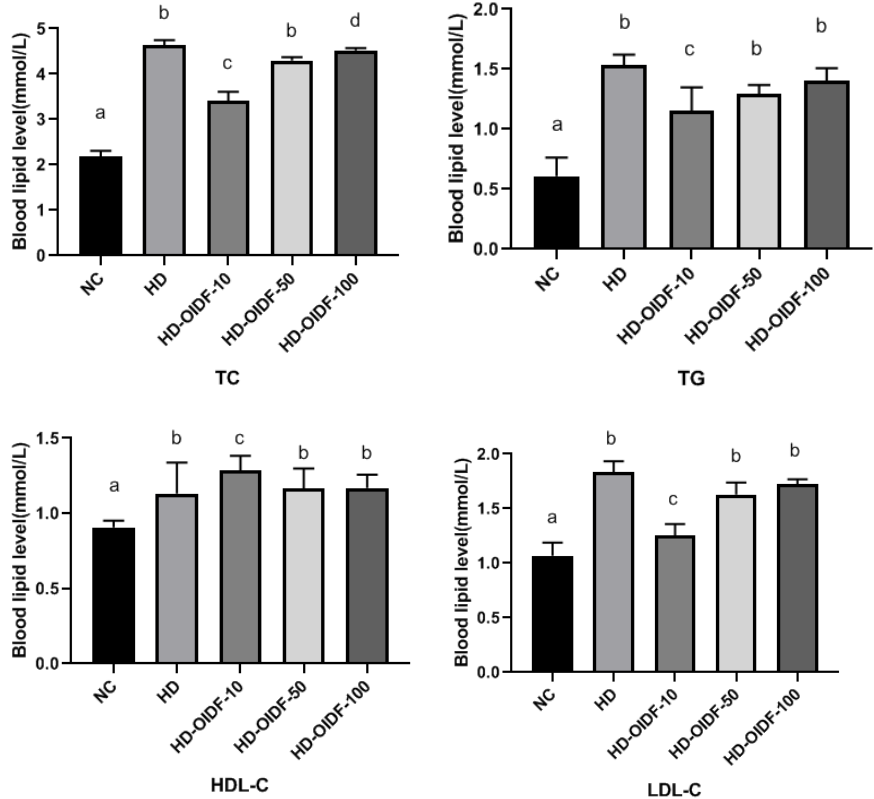
Figure 4. Effects of different particle sizes of OIDF on blood lipid levels in rats (TC, TG, HDL-C, LDL-C). Different letters in the same column (a, b, c and d) are significantly different ( p < 0.05). The results are expressed as mean ± SD ( n = 3).